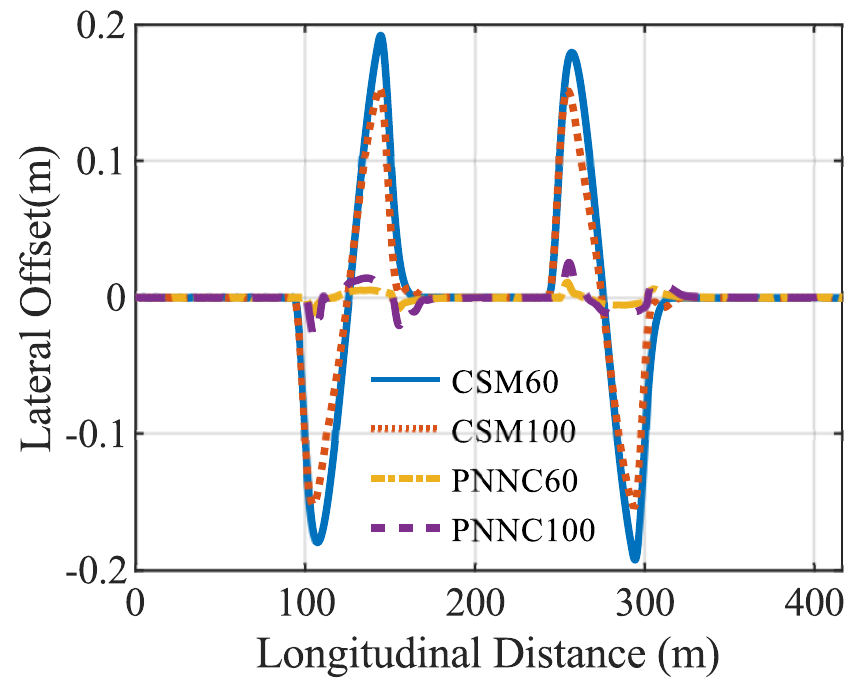
Figure 4. Lateral offset of the pure pursuit Model Predictive Control (MPC) controller and the proposed Neural Network controller (PNNC) for v x = 60 km/h and v x = 100